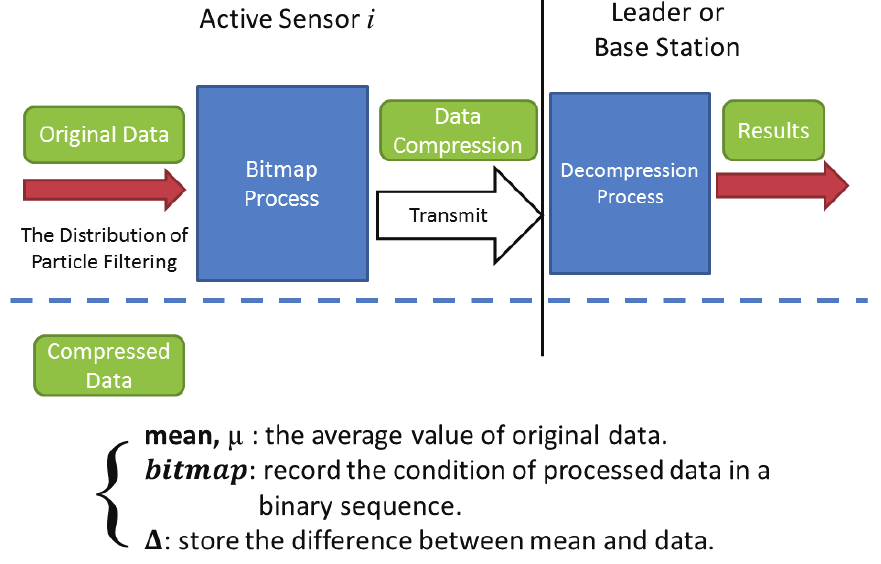
Figure 9. The conceptual processes of the CTCI